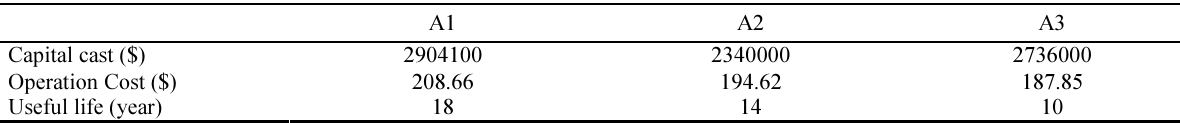
Fig. 3. Schematic diagram of the proposed model Table 3. Some basic features of